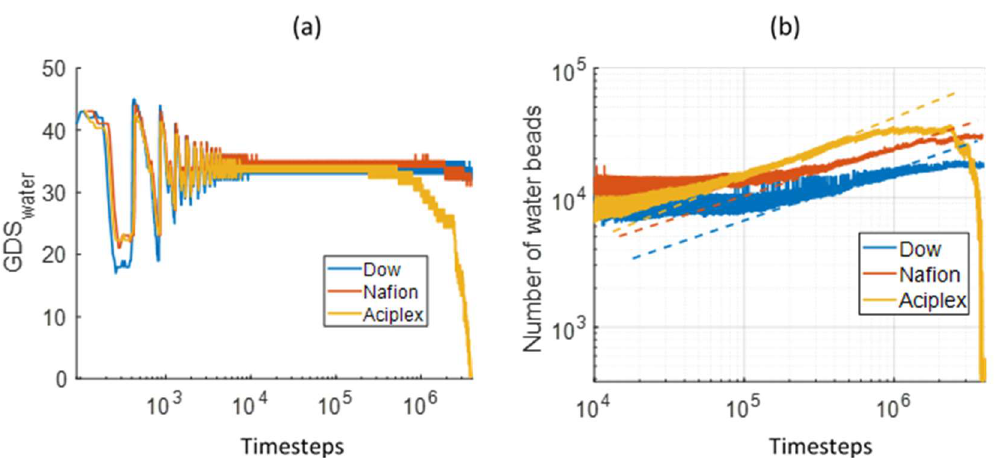
Figure 6. Comparison of ( a ) the temporal evolution of the Gibbs dividing surface (GDS) for water for different side-chain length PEMs, and ( b ) time dependence of the number of water beads between GDSwater and bottom Z boundary for different side-chain length PEMs. The yellow dotted line in (b) has a slope of 0.5, and the orange and blue dotted lines in (b) have slopes slightly less than 0.5.